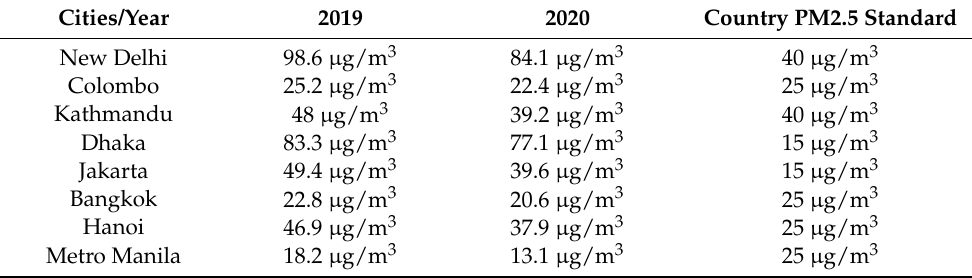
Table 4. Air quality in Asian cities (Annual average